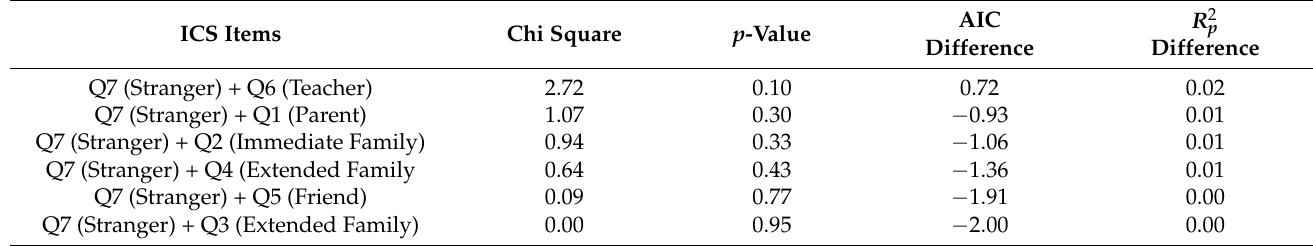
Table 4. Likelihood ratio test, AIC differences, and pseudo R-squared differences when comparing the beta regression model of Q7: Stranger as a predictor with all potential two-predictor models.